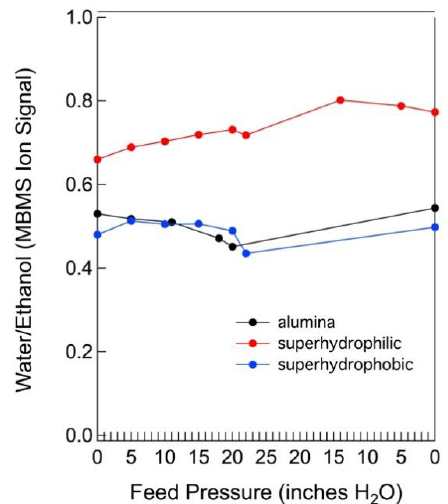
Figure 5. Evaluation of vapor phase ethanol–water separation selectivity for three types of membrane surfaces (alumina coated membrane, superhydrophilic, and superhydrophobic surface modified membranes [membrane #0, #8, and #12, respectively]). A molecular beam mass spectrometer (MBMS) was used to monitor the composition of the permeate as a function of feed pressure through a membrane.